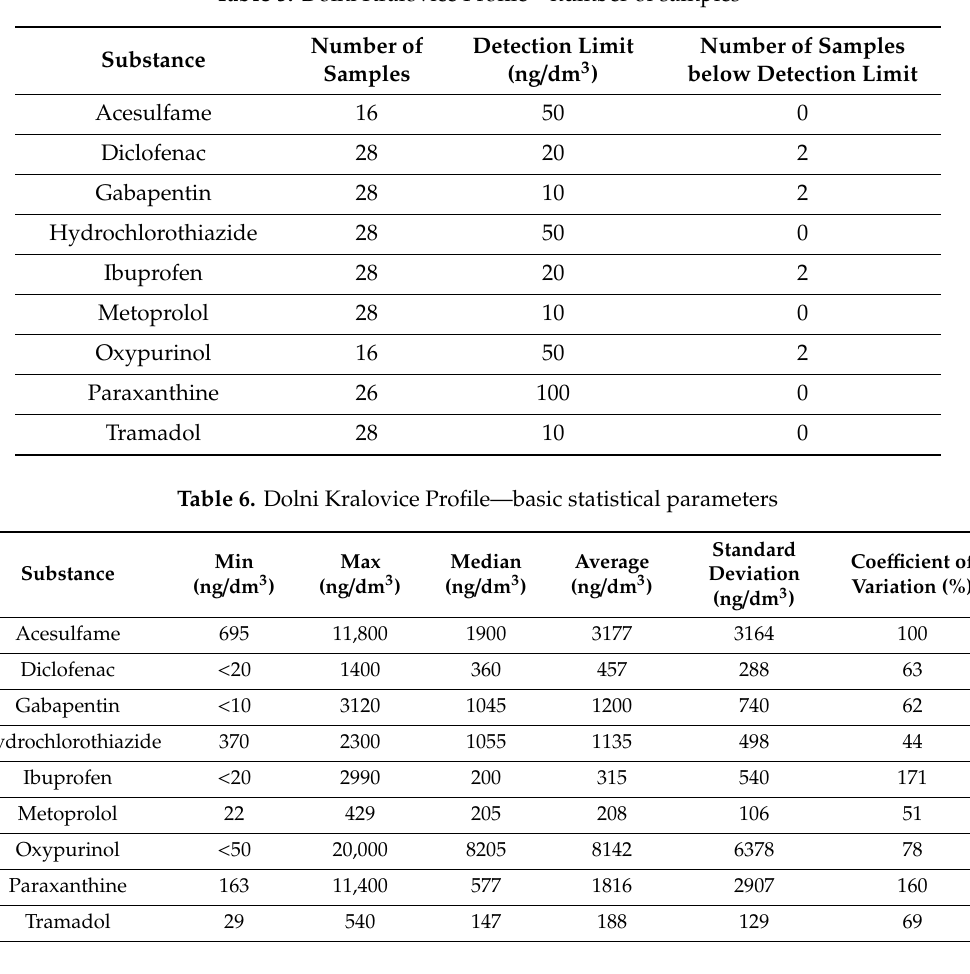
Table 5. Dolni Kralovice Profile—number of samples